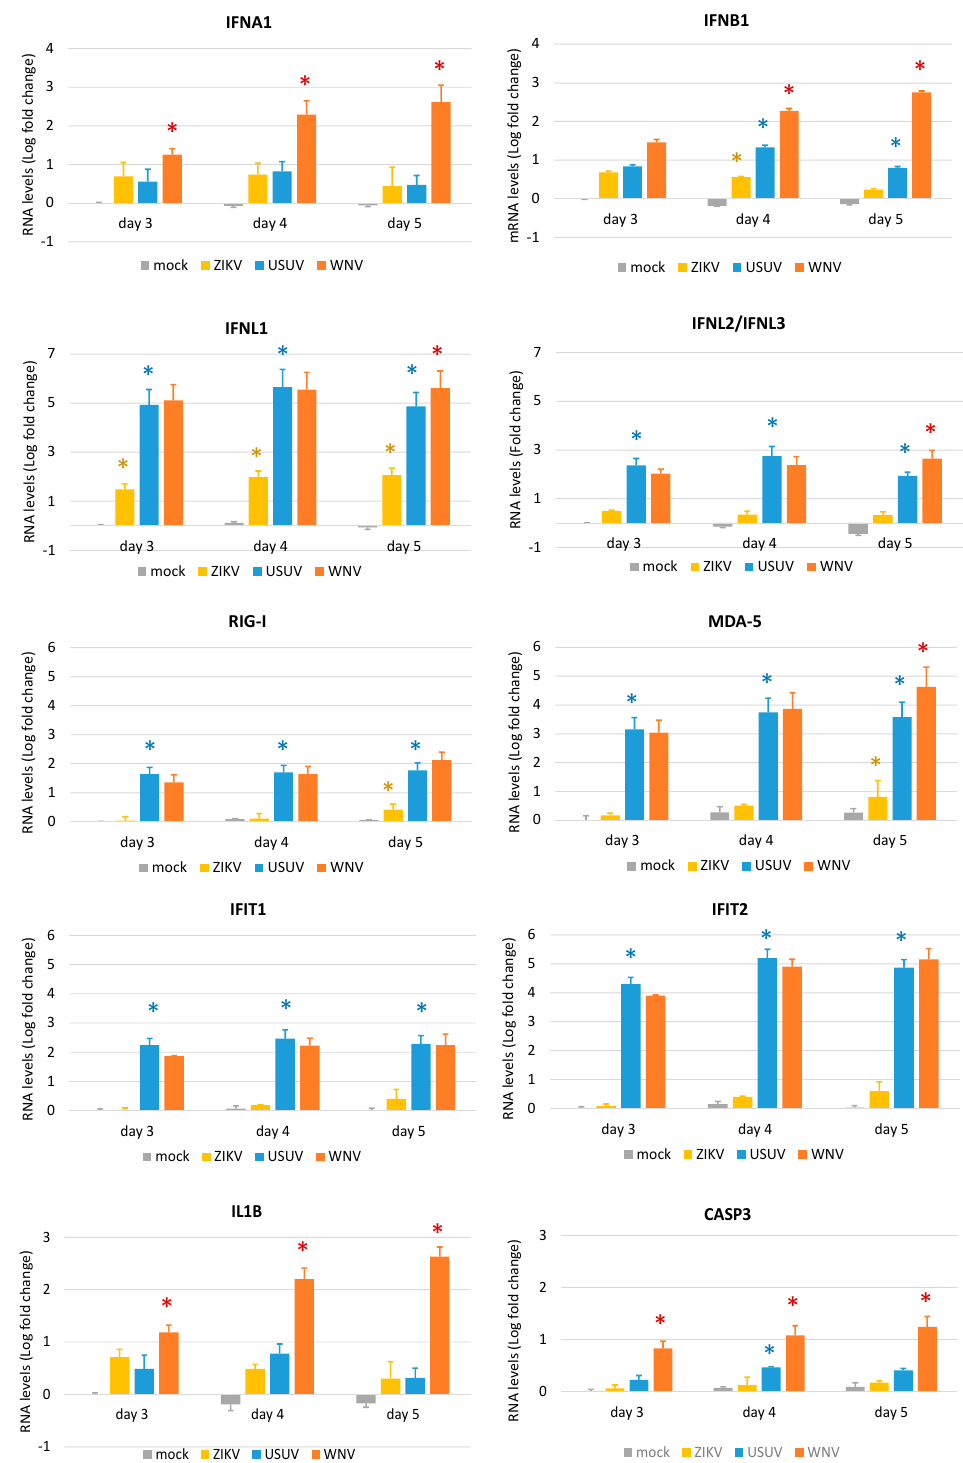
Figure 8. Antiviral innate immune response to WNV, USUV and ZIKV infection. qRT-PCR analysis of innate antiviral immune response gene expression in hNSC line 1 at 3, 4 and 5 dpi with WNV lineage 1, USUV Europe 1 and ZIKV Asian lineage at MOI 0.1. RNA levels are represented as geometric mean ± SD of Log fold change (compared to mock infection at day 3). Analyses were performed in quadruplicated experiments. * WNV vs. USUV; * USUV vs. ZIKV; * ZIKV vs. mock; p < 0.05; Student’s t